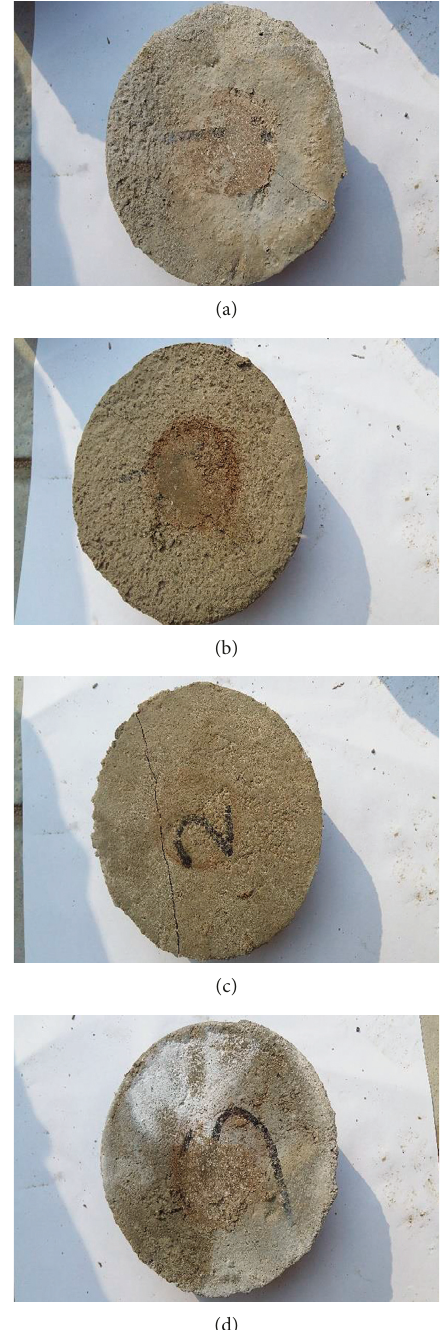
Figure 20: Photographs of fracture shape after impact test. (a) 40MPa (control). (b) 40MPa (optimum). (c) 60MPa (control). (d) 60MPa